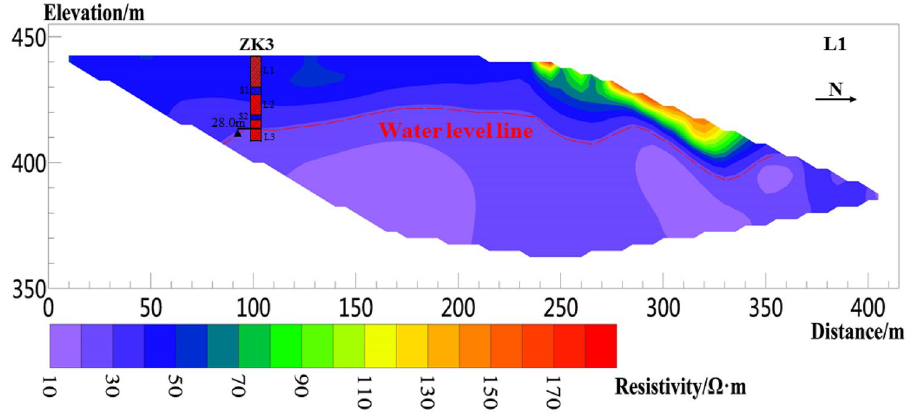
Figure 9. Resistivity profile of line L1.